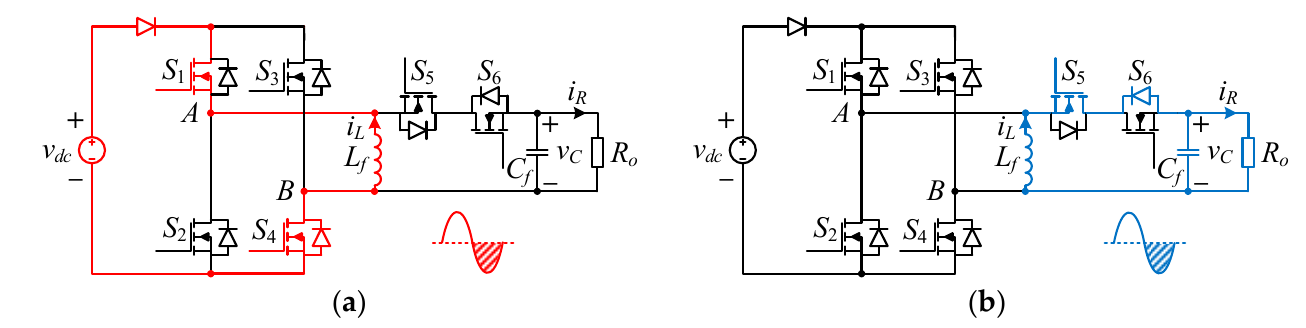
Figure 3. Switching patterns for the negative half-wave of v c : ( a ) Inductor charged, ( b ) Inductor Figure 3. Switchingpatternsforthenegativehalf-waveof v c : ( a )Inductorcharged, ( b discharged.